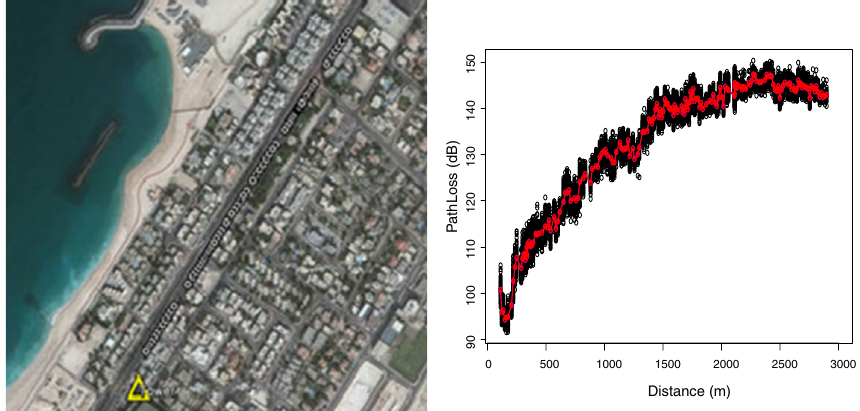
Fig. 4 (Left) aerial view of field measurements area; (right) measurements and their